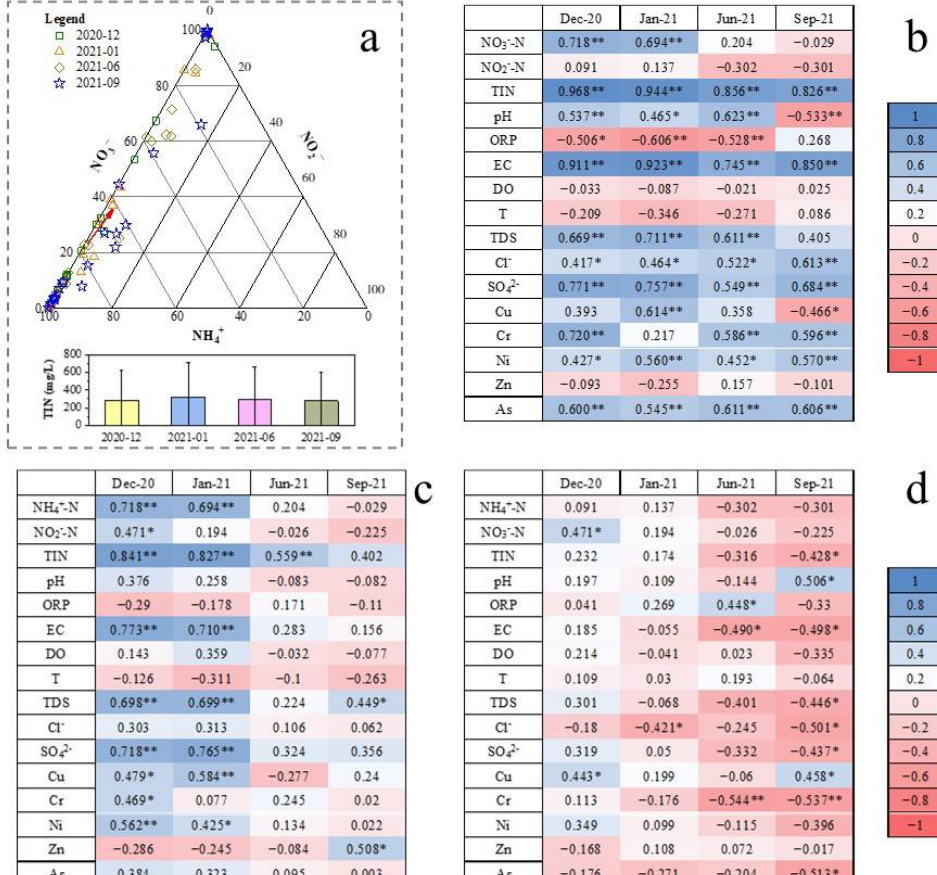
Figure 8. Temporal variation of DIN species and TIN concentration, and the Spearman correlation between inorganic nitrogen and environmental indicators (physicochemical parameters, major anion, and heavy metal). ( a ) The proportion of NH 4+ -N, NO 3 − -N, and NO 2 − -N, and the red arrow represents the direction of the change in the average proportion; the average TIN concentration, and the error bars represent the standard deviation. ( b ) the Spearman correlation between NH 4+ -N and environmental indicators. ( c ) the Spearman correlation between NO 3 − -N and environmental indicators. ( d ) the Spearman correlation between NO 2 − -N and environmental indicators. * p < 0.05, ** p < 0.01.